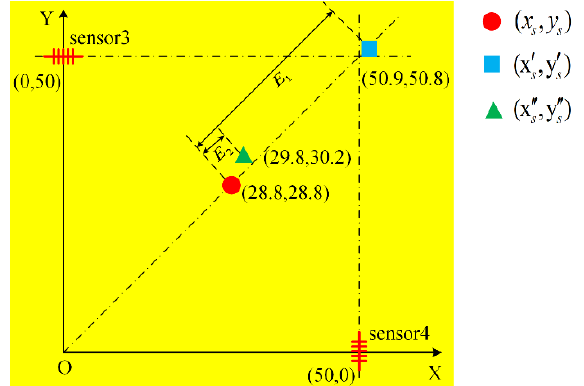
Figure 11. The result of the location experiment.